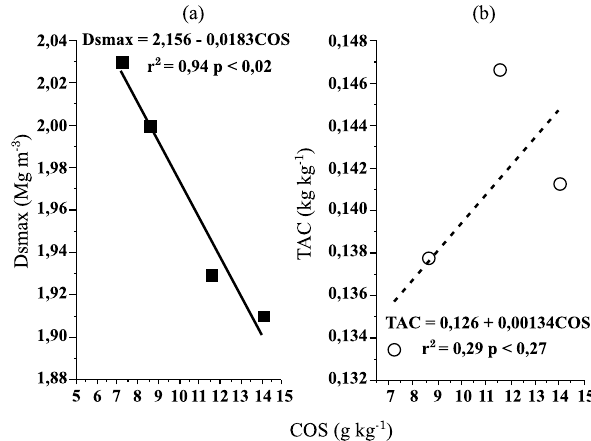
Figura 3. Correlação entre a densidade do solo máxima (Dsmax) e os teores de carbono orgânico do solo (COS) (a); correlação entre os teores de água crítico (TAC) e os teores de COS nas áreas estudadas